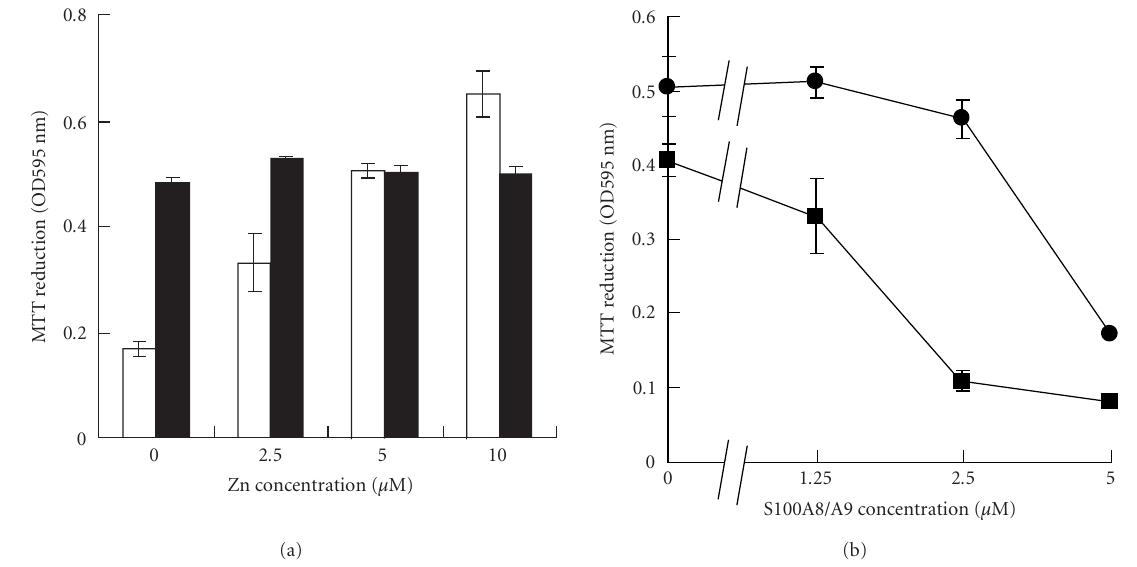
Figure 4. Zinc inhibits apoptosis-inducing activity of S100A8/A9 complex against MM46 cells. (a) MM46 cells were cultured without (open column) or with (filled column) 5 µ M S100A8/A9 in the presence of the indicated concentrations of zinc sulfate for 24h. (b) Augmentation of the apoptosis-inducing activity of S100A8/A9 in divalent cation-depleted medium. MM46 cells were cultured with • ) or divalent cation-depleted medium ( (cid:1) ) for 24h and the viability was evaluated by 10 µ M S100A8/A9 in the standard medium ( MTT assay. Bars represent standard